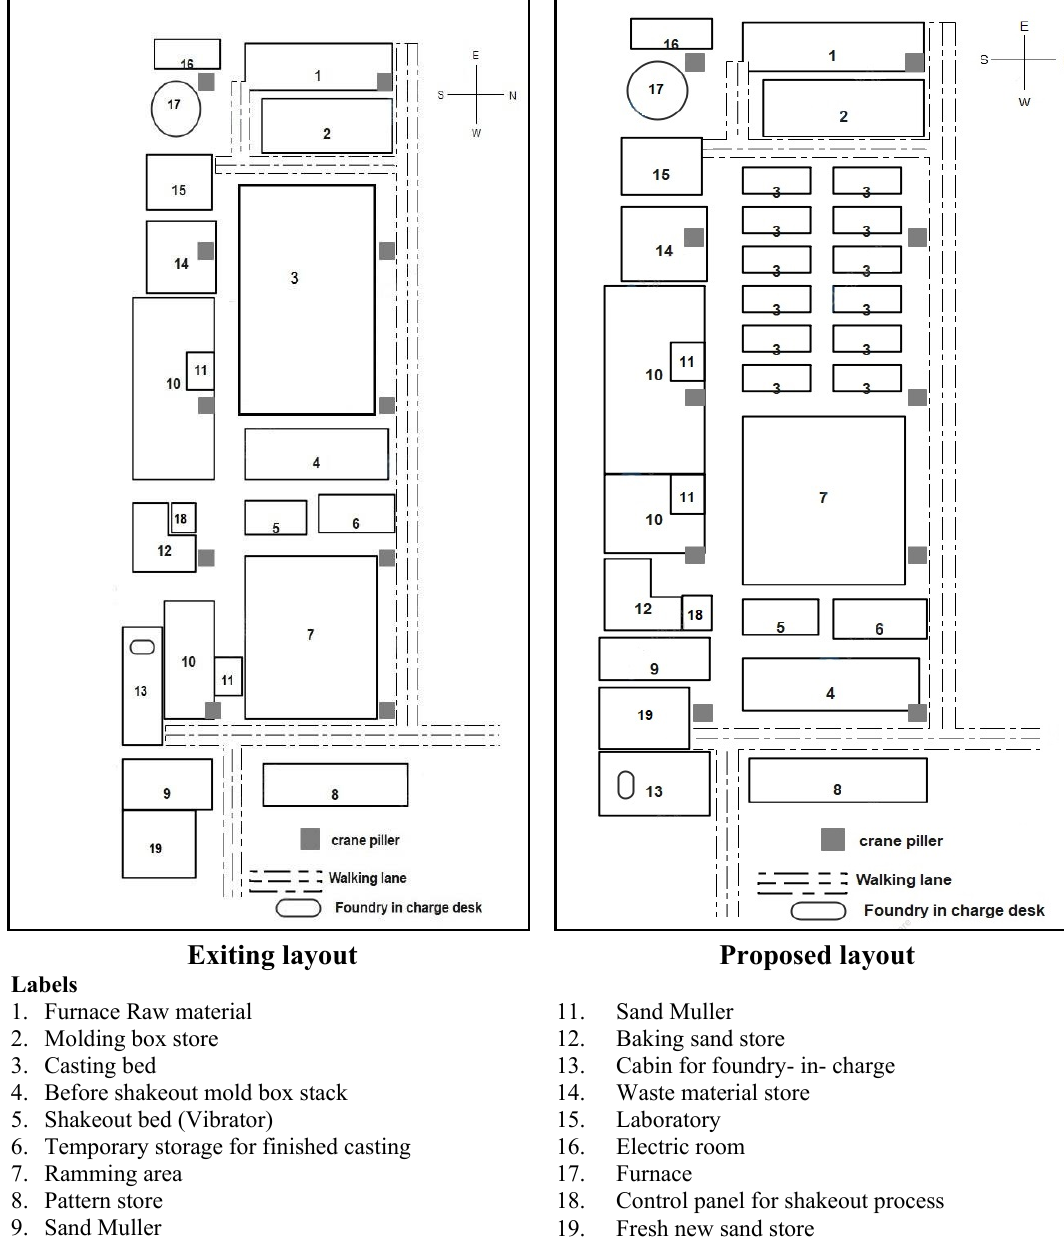
Fig. 10 . Existing and proposed